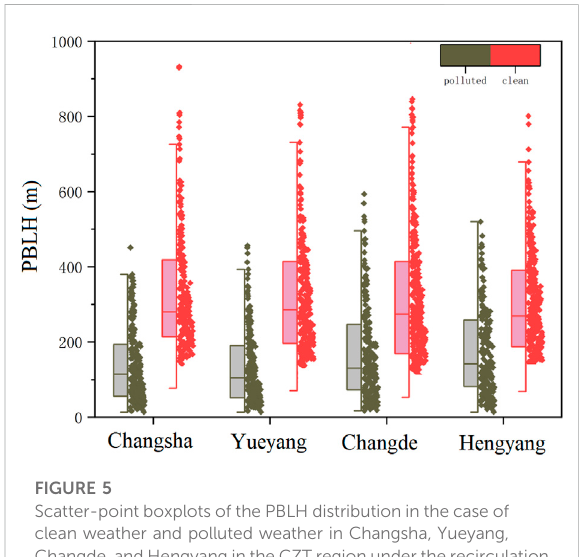
FIGURE 5 Scatter-point boxplots of the PBLH distribution in the case of clean weather and polluted weather in Changsha, Yueyang, Changde, and Hengyang inthe CZT region under therecirculation wind fi